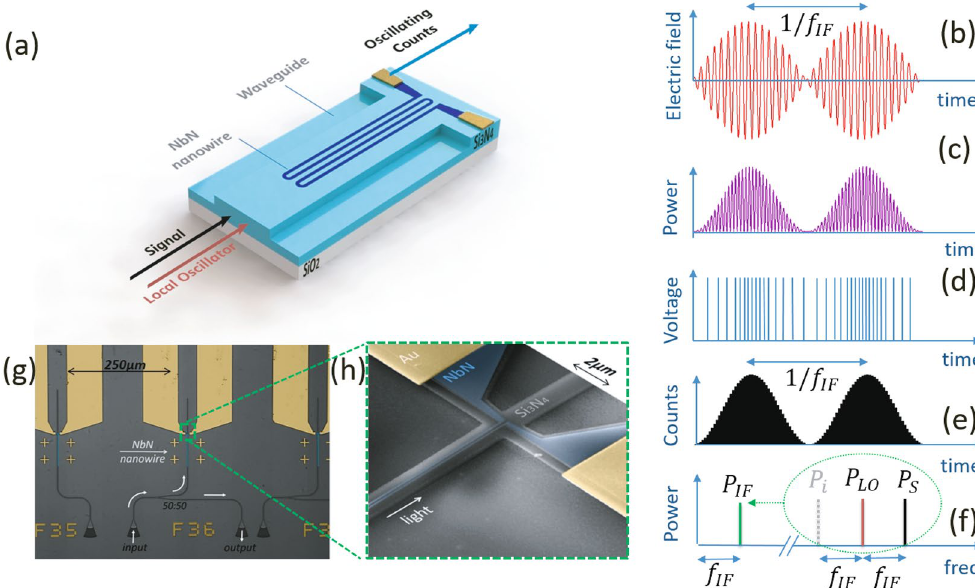
Figure 1. Operation principle of a SNSPD as a coherent detector and layout. ( а ) Schematic view of the SNSPD in coherent detection mode, in which two EM waves with slightly different frequencies ( f LO , f S ) are sent to the SNSPD. ( b ) Time domain beating of the EM-field generated overlapping LO and S fields, with slightly different frequencies. ( с ) Power oscillation in time at an intermediate frequency f IF = | f LO − f S |. ( d ) Schematic representation of the detection pulses frequency modulation in presence of beating, which reproduces the optical power amplitude modulation. ( e ) Schematic view of the counts histogram vs time. By measuring the frequency of the counts oscillations f IF and knowing the f LO , one can determine the frequency of the unknown signal f S = | f LO − f IF |. ( f ) Representation of the coherent detection in the frequency domain. The intermediate frequency is transferred from the IR range to a lower frequency. In addition to the signal and LO, the image channel contributes noise to P IF . ( g ) False color optical micrograph of the nanophotonic devices. Each device consists of two focusing grating couplers, nanophotonic waveguides with a 50:50 Y-splitter, where one branch reaches a NbN nanowire connected to Au contact pads. ( h ) False color SEM image of a typical NbN nanowire atop a nanophotonic